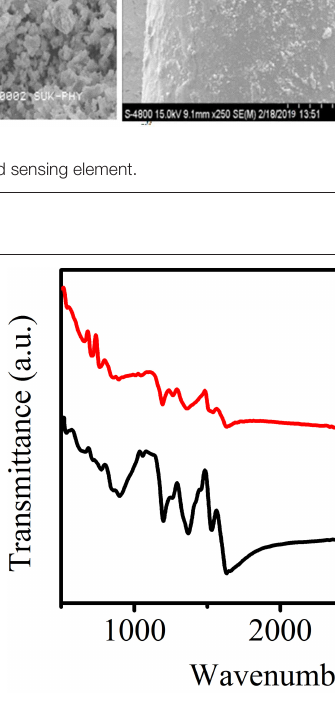
FIGURE 5 | FTIR Spectrum of PANI and